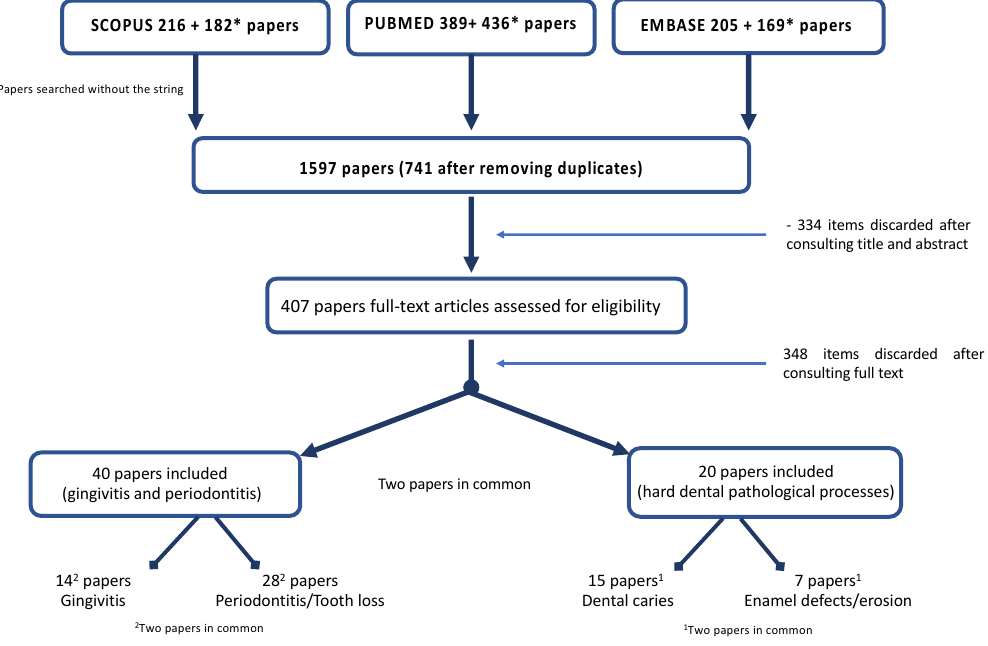
Figure 1. Flow chart of the search.